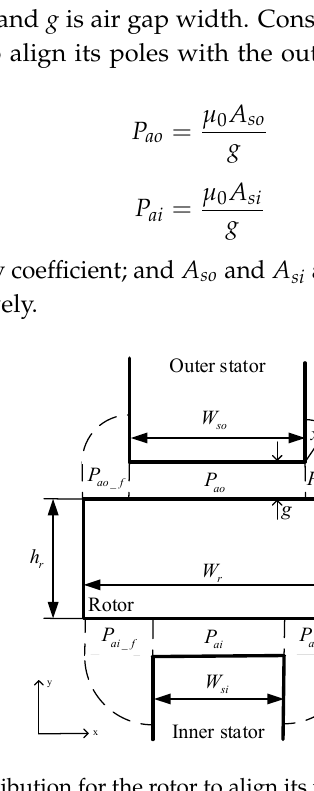
Figure 4. Permeance distribution for the rotor to align its poles with the excited stator poles.